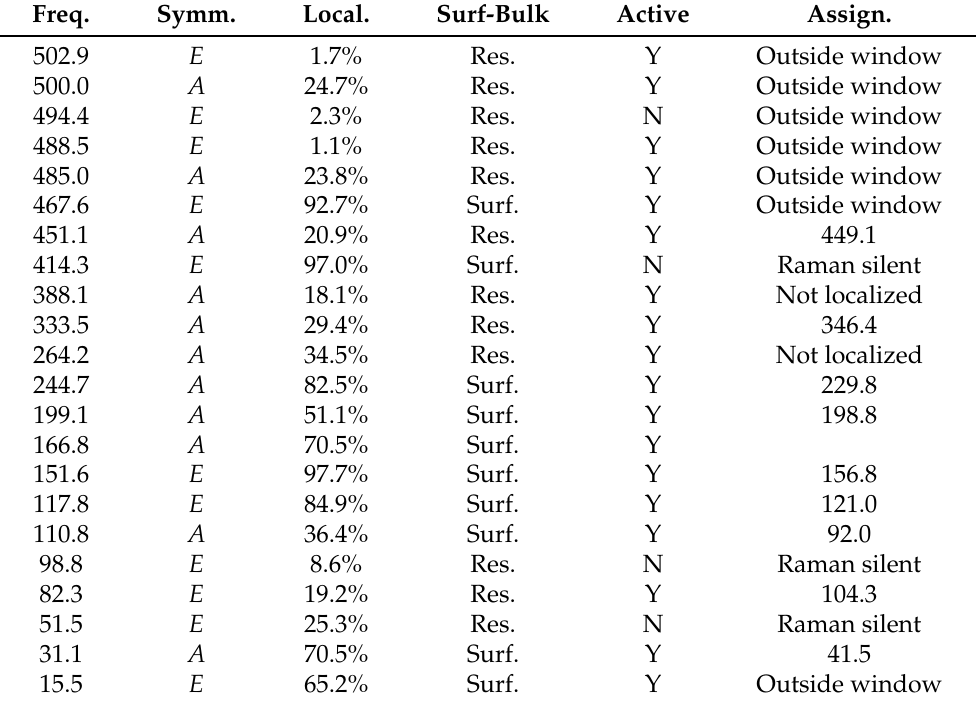
Table 3. Raman frequencies (in cm − 1 ) calculated for the terbium silicide monolayer with (1 × 1) periodicity within DFT-PBEsol. Surface localization, mode symmetry, Raman activity, and possible assignment to the measured Raman signatures are